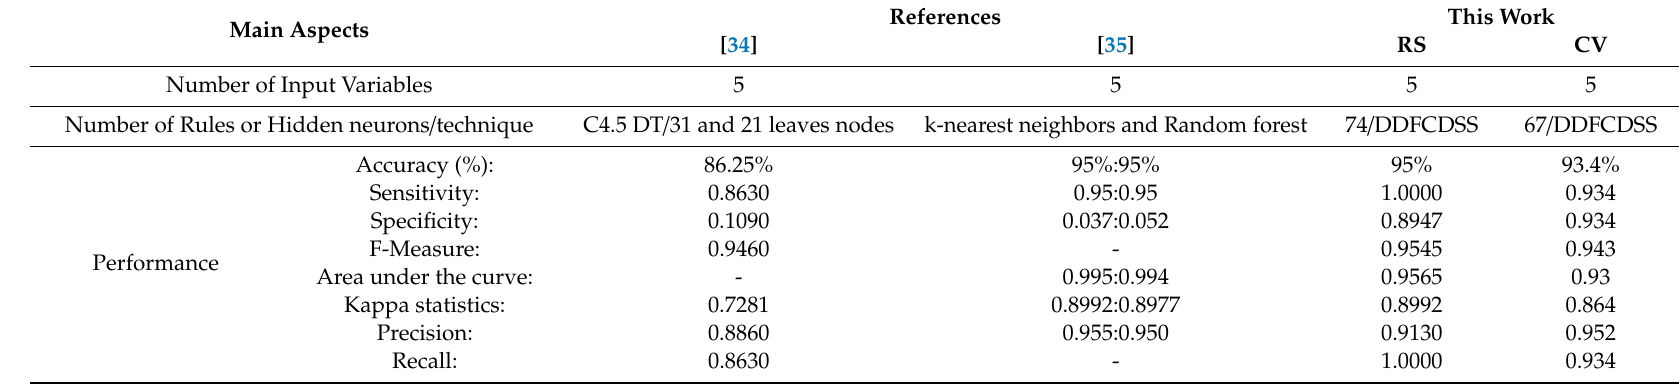
Table 13. Performance metrics obtained with our proposed framework and other classifiers obtained from the literature for a caesarean section dataset. Main